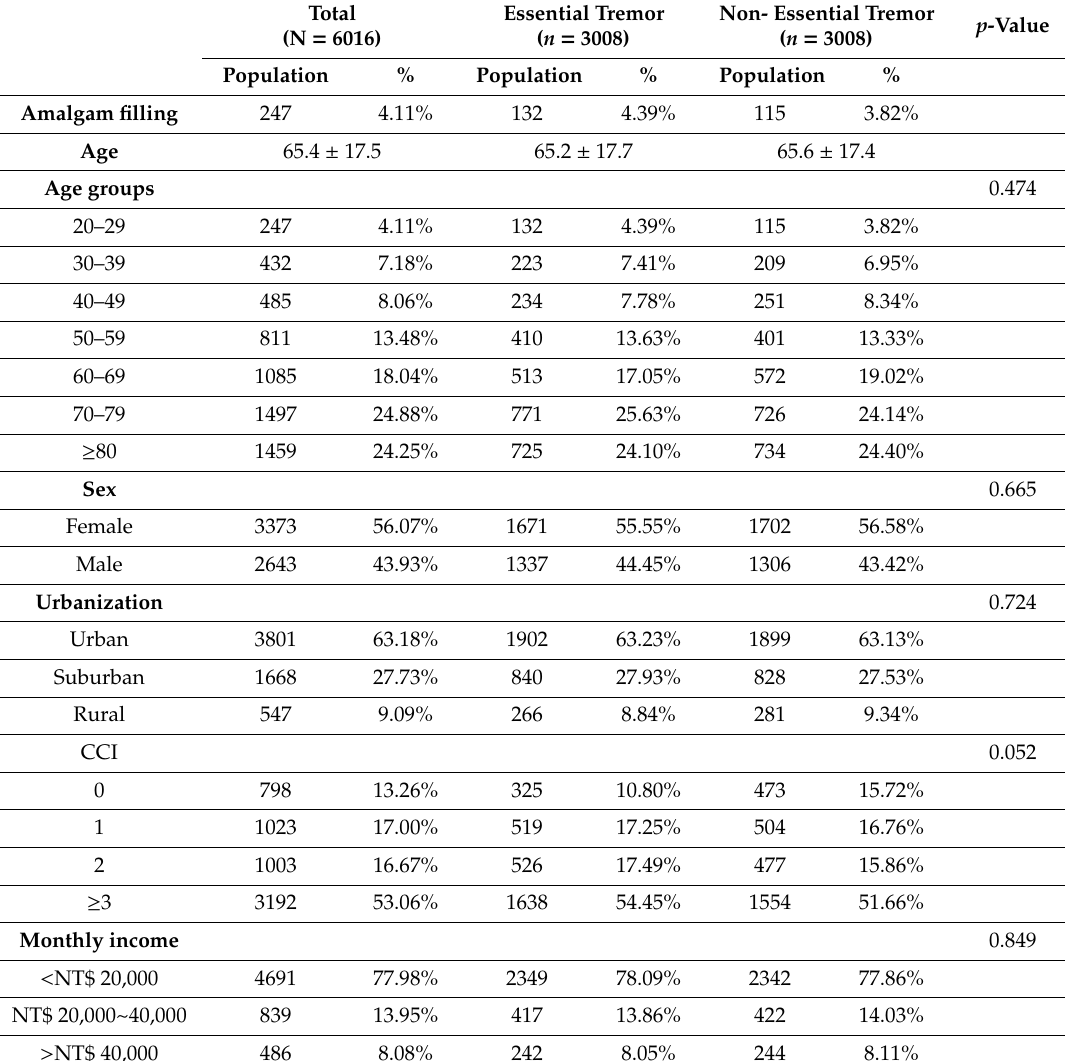
Table 2. Demographic characteristics of individuals in this